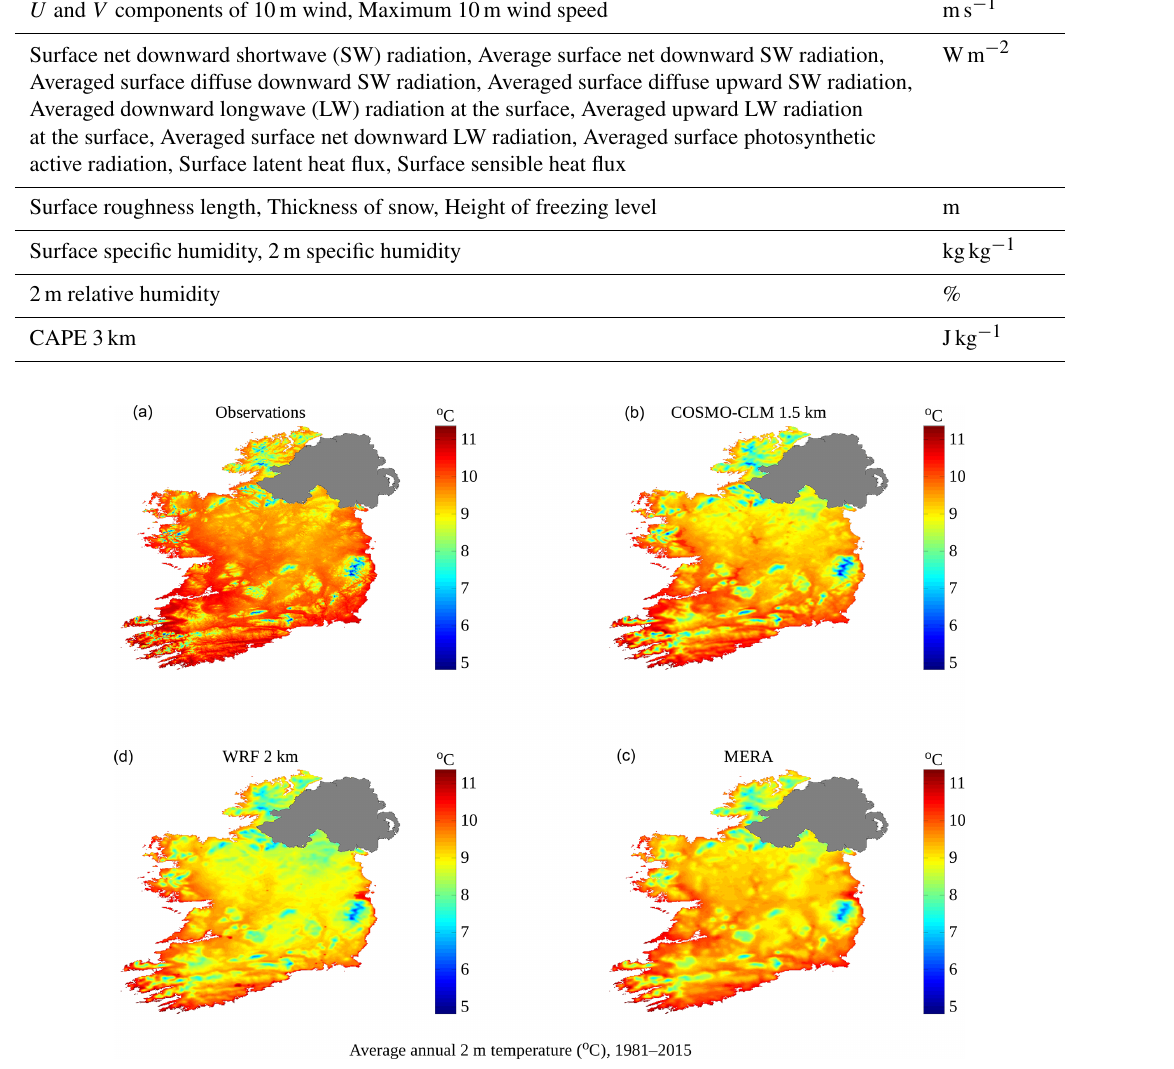
Figure 2. Average annual temperature ( ◦ C) for the period 1981–2015. Shown are the values found from (working clockwise): (a) gridded observations provided by Met Éireann; (b) the COSMO-CLM 1.5km dataset; (c) the MÉRA dataset; (d) the WRF 2km